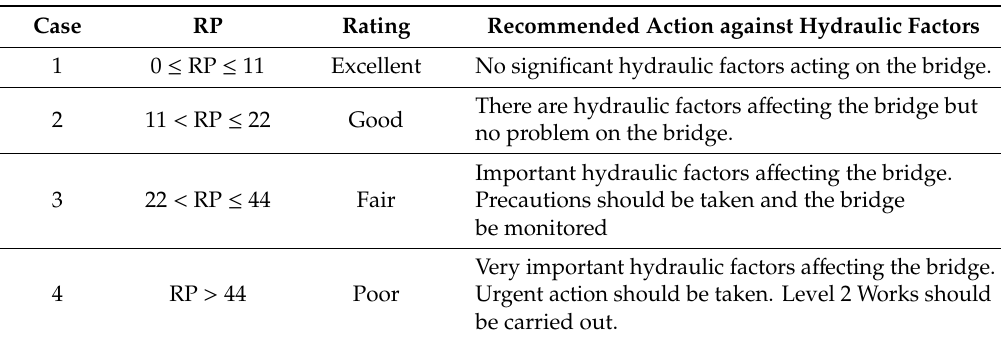
Table 11. Evaluation of river bridges in terms of